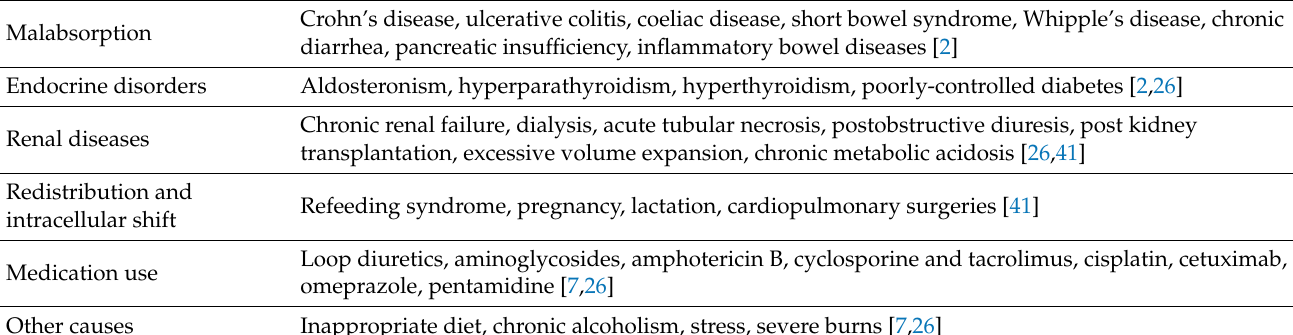
Table 2. Conditions leading to